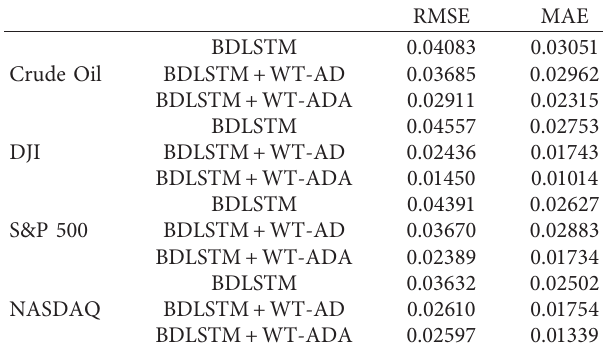
Figure 5: Five-level decomposition of Crude Oil closing price using SWT ( s : input data; cA level i ; cD i : detail coefficients at decomposition level i ). Table 4: Simulation results and performance comparison of three configuration systems for Crude Oil commodity and Dow Jones industrial average, S&P 500, and NASDAQ Composite indexes. As evaluation criteria, RMSE and MAE are